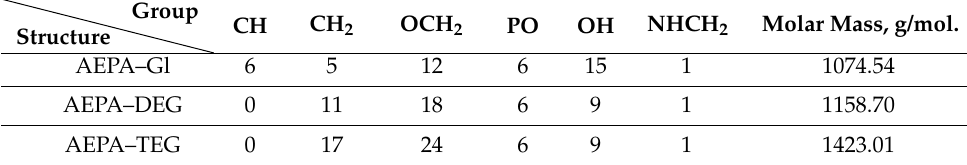
Figure 1. Residual curves (geometric figures are experimental data) for the ethanol–water–AEPA- (PEG/DEG/TEG/Gl) mixture, [AEPA-(PEG/DEG/TEG/Gl)] = 60 wt.%. Solid line is calculated data for the binary ethanol–water mixture. Dashed line is the calculated data for the ethanol–water–AEPA- Gl mixture. P/L 0 is the distillate rate. Table 1. Group composition of AEPA-(DEG/TEG/Gl)